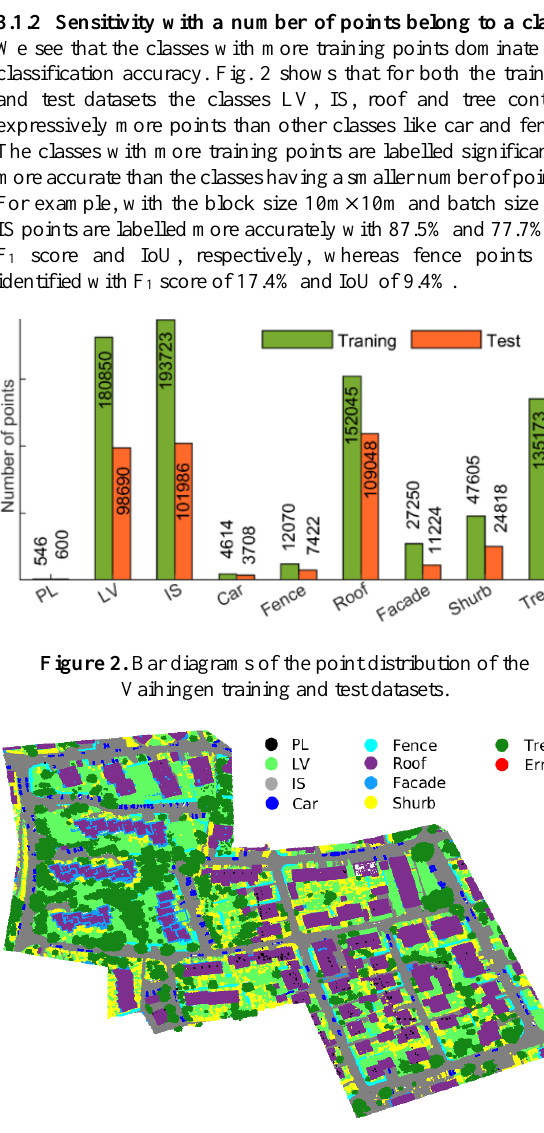
Figure 3. Vaihingen training dataset with ground-truth labels in different